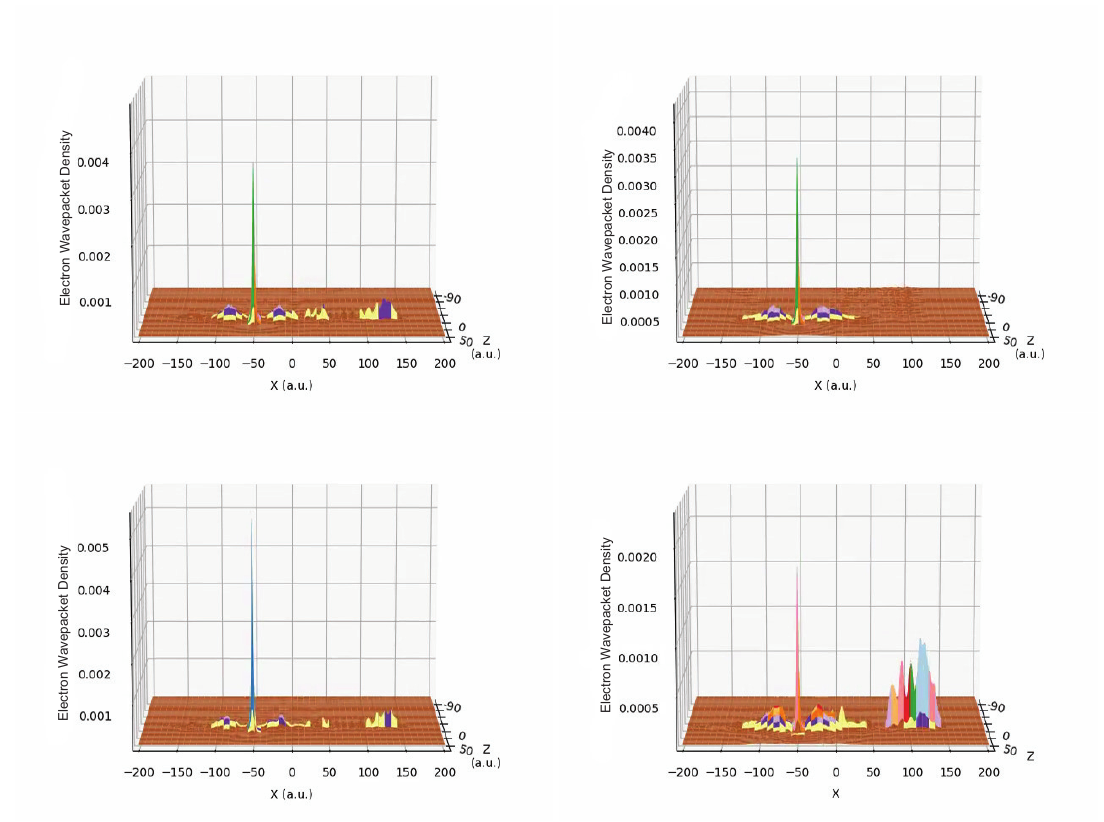
Figure 8. Time-snapshots of the electron wave packet density: ( a ) for the vicinal Cu(111) of d = 5 a s at the time t where the ion strikes the center of the step; ( b ) for the vicinal Cu(111) of d = 5 a s at the same instant of ( a ) but where the ion strikes the peak of the step; ( c ) for the vicinal Au(100) of d = 5 a s at the same instant of ( a ) where the ion strikes the center of the step; ( d ) for the vicinal Pd(111) of d = 5 a s at the same instant of ( a ) where the ion strikes the center of the step. The electron wave packet density is a dimensionless fraction which is normalized to unity over all